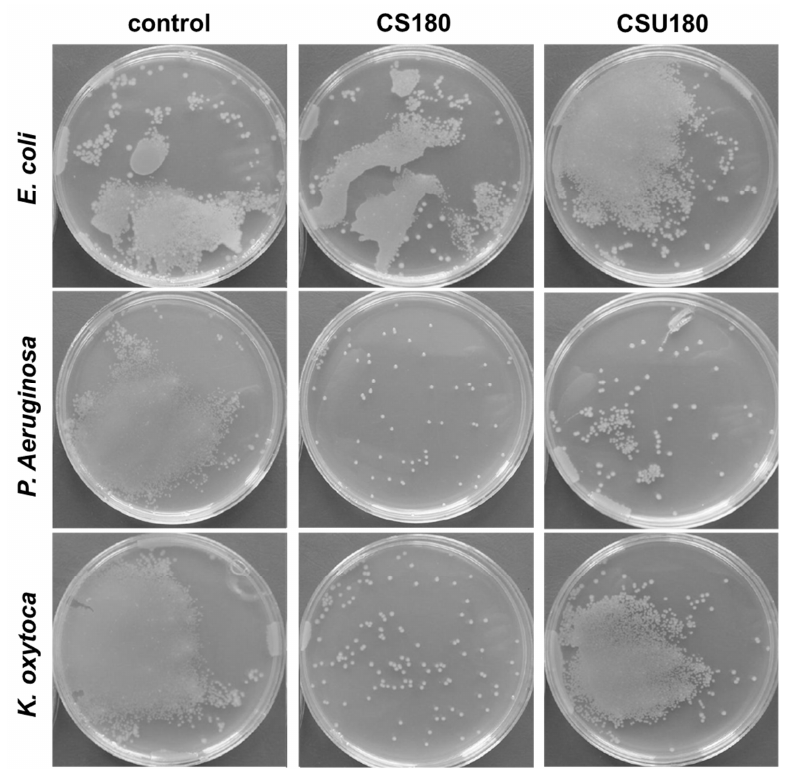
Figure 8. Microbiological